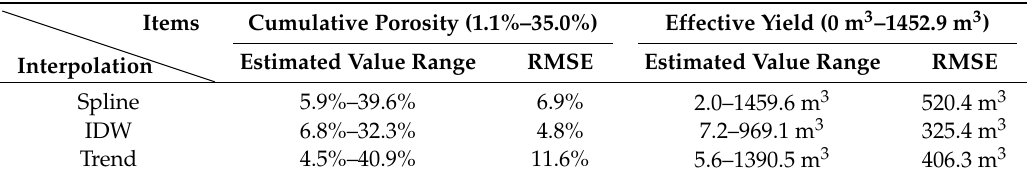
Table 3. Some found rules related to cumulative pore volume and effective yield. Table 4. Cross-validation of the deterministic interpolation